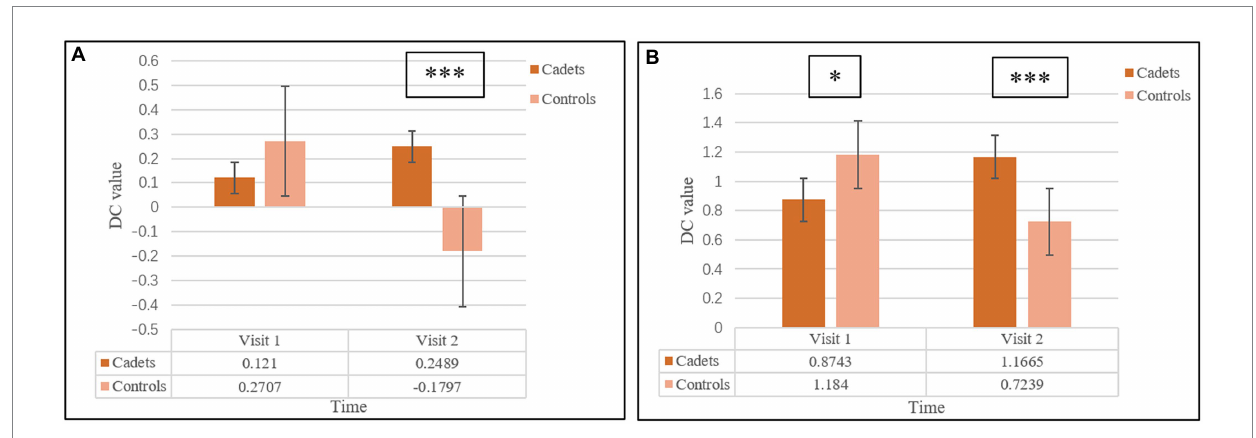
FIGURE 2 Detailed information of the interaction effect of the two groups at the two visits. (A) represented the detailed information of the left middle frontal gyrus; (B) represented the information of the lingual gyrus. One star represented the p < 0.05, three stars represented the p <